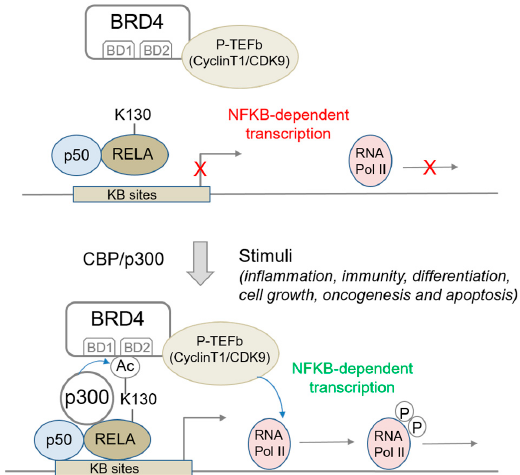
Figure 2. Schematic model for the binding of BRD4 to acetylated lysine-310 of RELA/p65 and the role